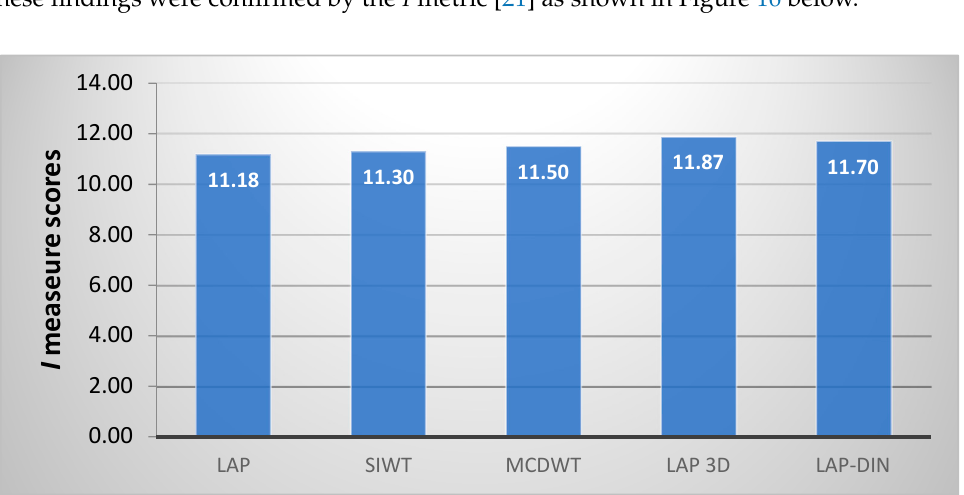
Figure 16. Comparing results of objective measure I on six fusion methods (static and dynamic) on database set.